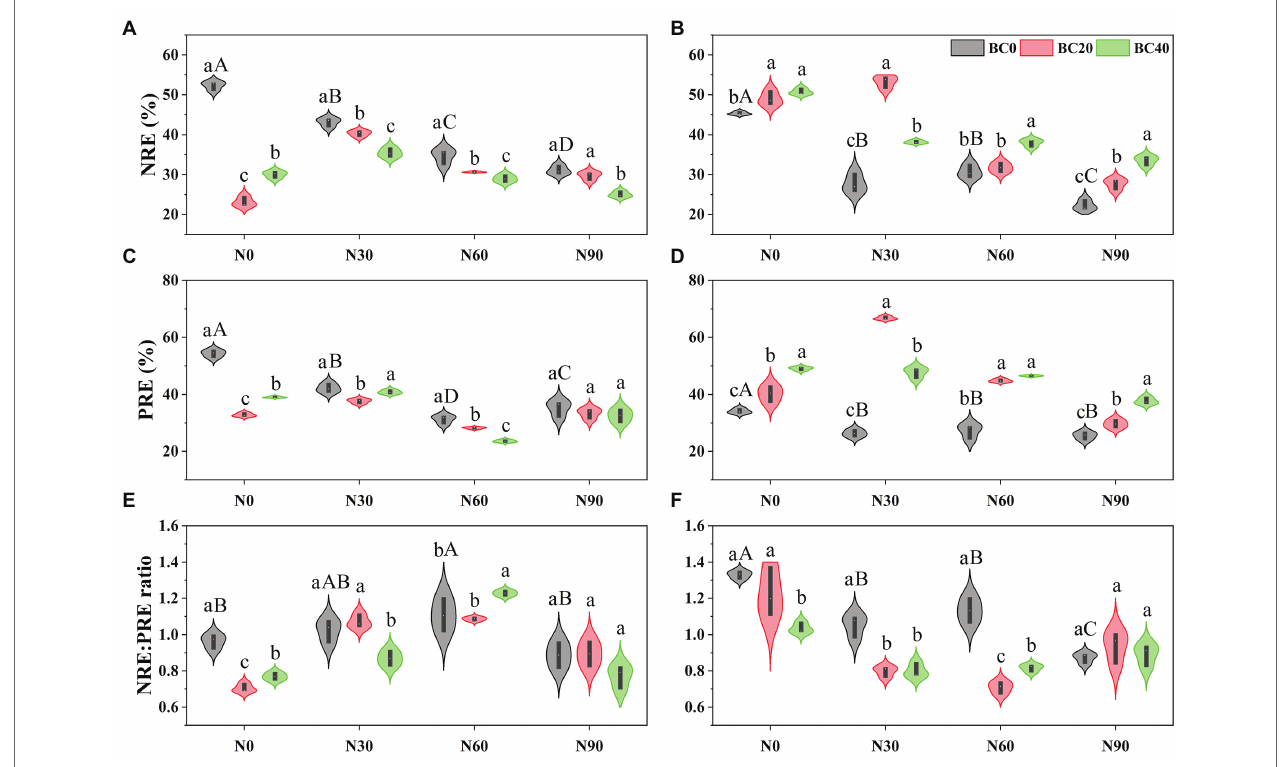
FIGURE 3 | Nitrogen resorption efficiency (NRE), phosphorus resorption efficiency (PRE), and NRE:PRE ratio of young (A,C,E) and mature (B,D,F) bamboo under different N addition and biochar amendment treatments. N0, N30, N60, and N90 refer to 0, 30, 60, and 90 kg N ha − 1 yr − 1 , respectively, and BC0, BC20, and BC40 refer to 0, 20, and 40 t biochar ha − 1 . Capital letters indicate a significant difference between different N addition treatments in the BC0 treatment at the 0.05 level. Lowercase letters indicate a significant difference between different biochar treatments in the same N addition treatment at the 0.05